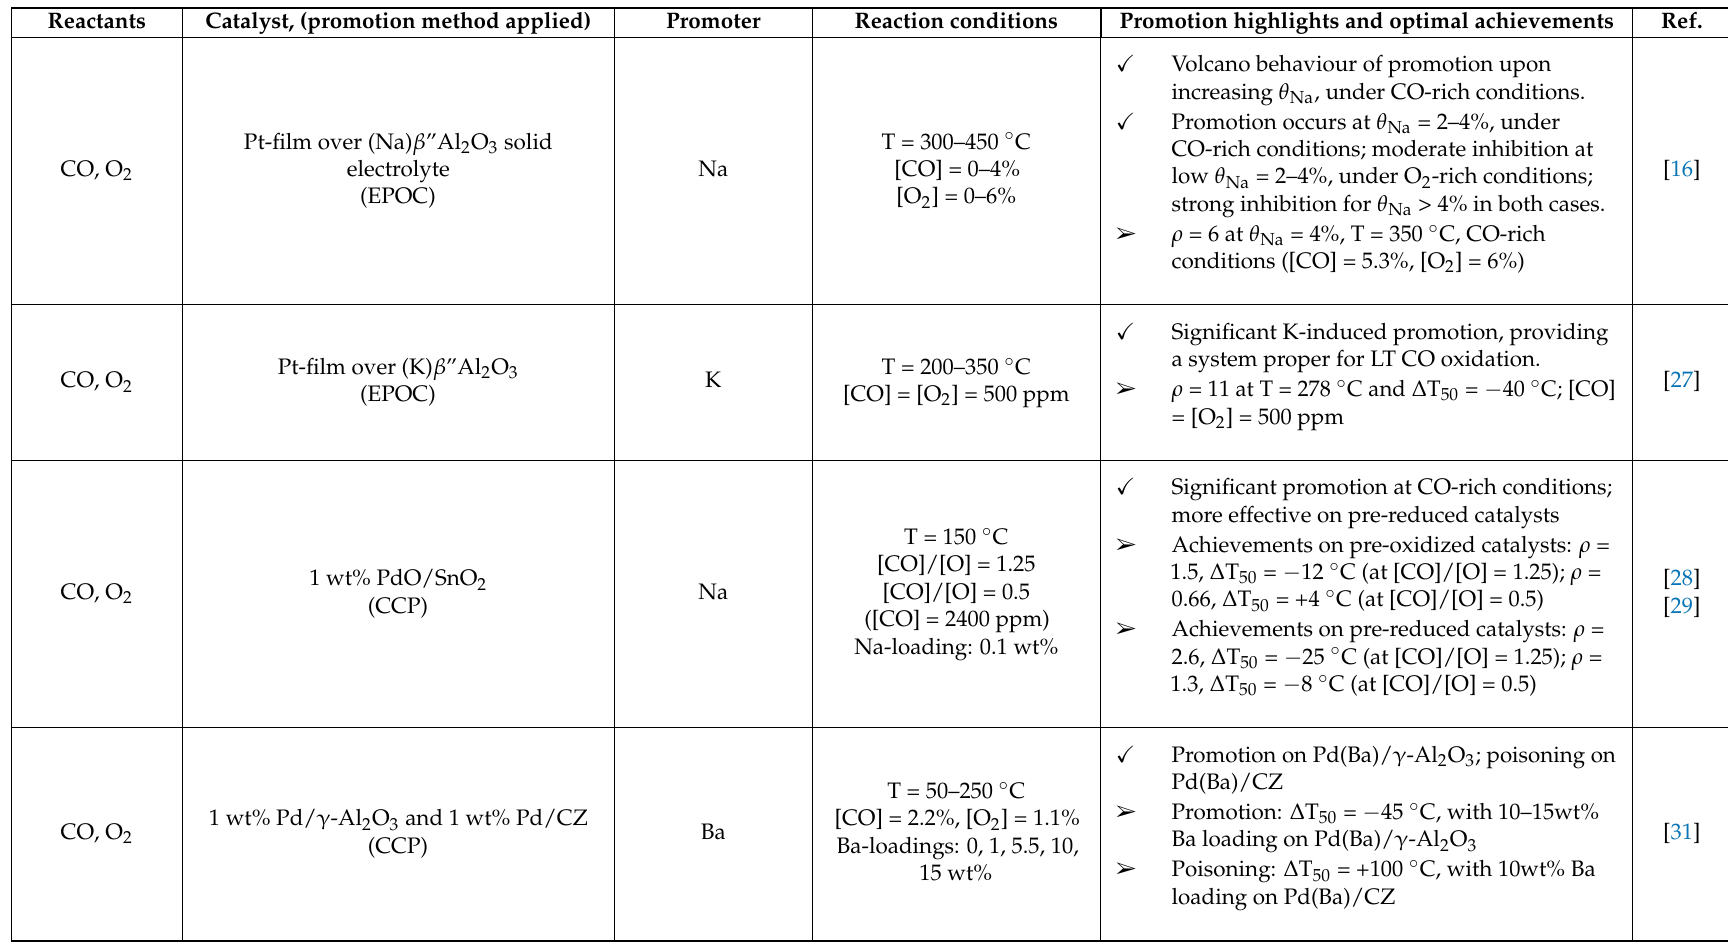
Table 1. Electropositive promotion of PGMs-catalysed CO oxidation (CO+O 2 ) and Preferential CO oxidation (PROX: CO+O 2 +excess H 2 ). Reactants